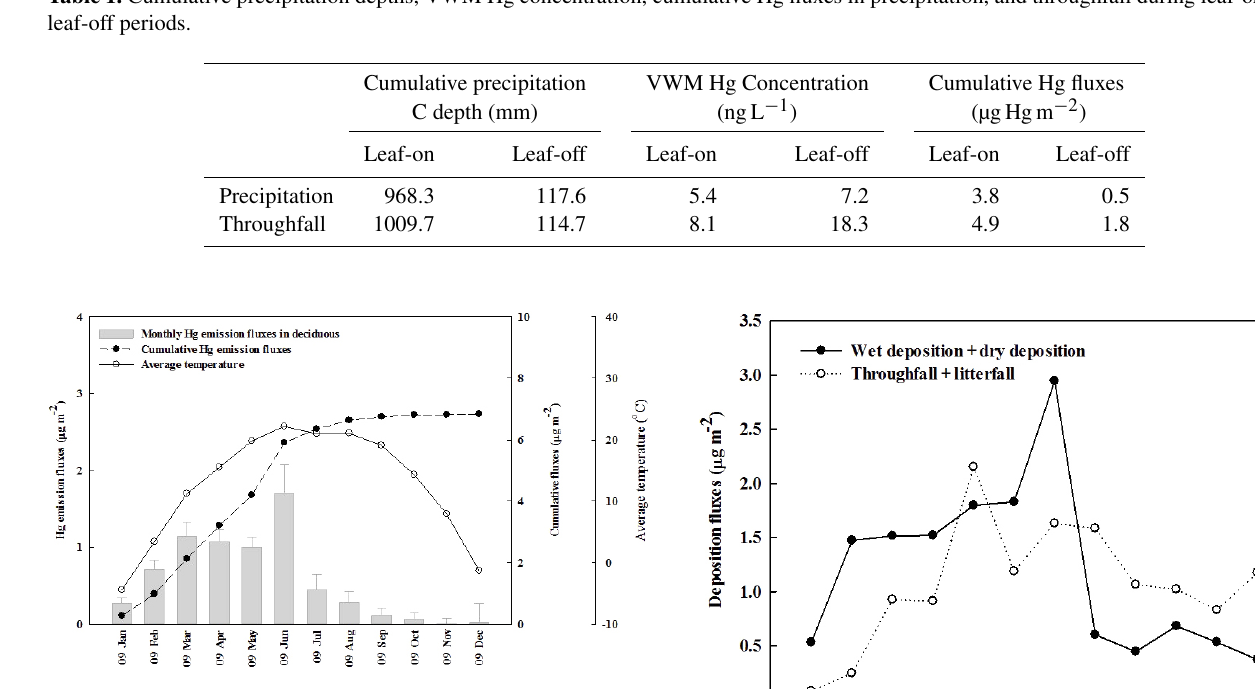
Figure 5. The estimated annual Hg emission fluxes in 2009 from soil.